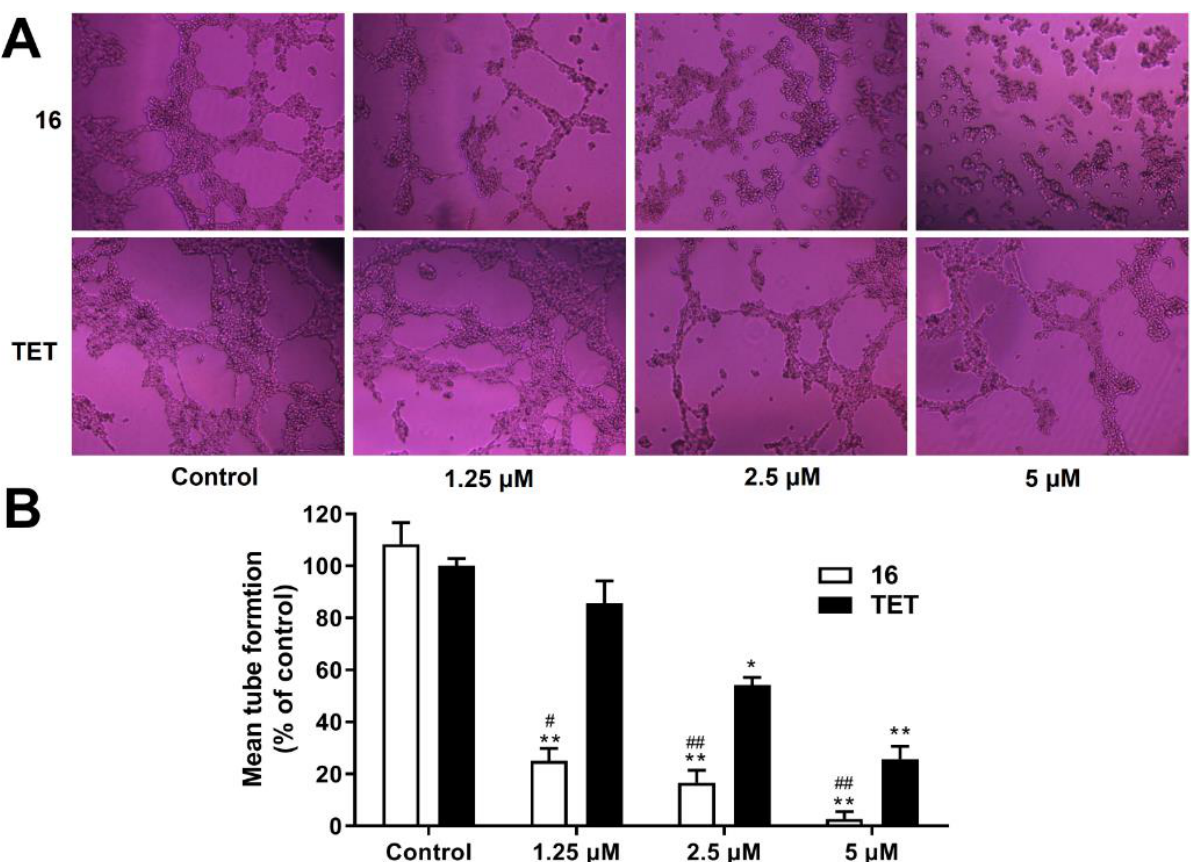
Figure 13. Inhibitory effect of 16 on the tube formation of HUVECs on Matrigel. ( A ) Representative images of the tube formation suppressed by 16 (1.25, 2.5, and 5 μ M) in HUVECs (×40). ( B ) Quanti- tative histogram analysis for the tube-forming capability. *: p < 0.05, **: p < 0.01 vs. control group; # : p < 0.05, ## : p < 0.01 vs.TET at the same concentration.